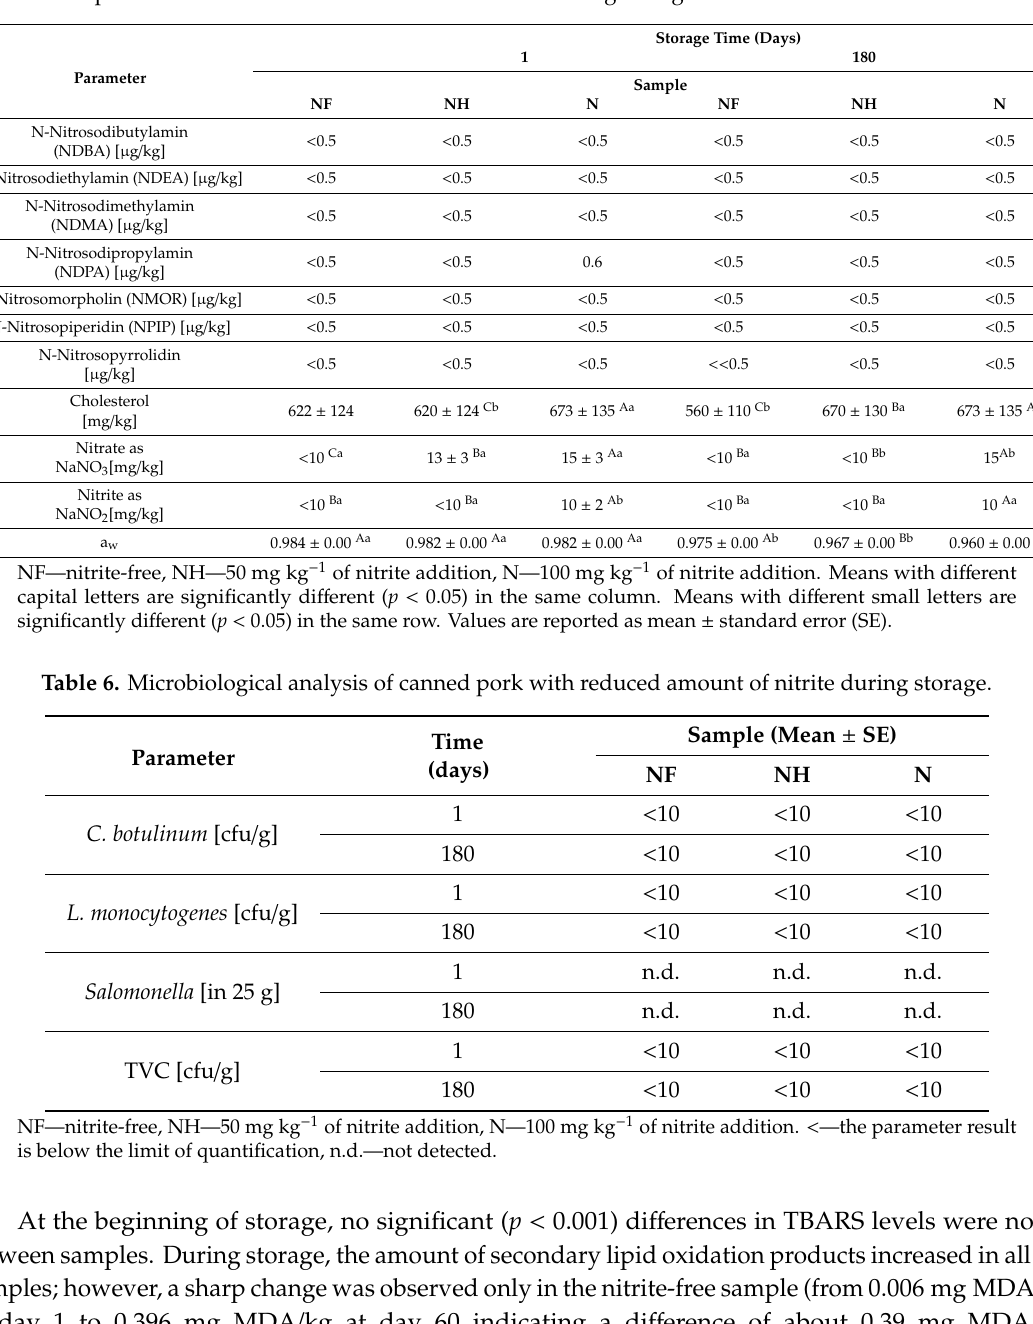
Table 5. Nitrosamine, cholesterol, nitrite and nitrate residues and water activity (a w ) amounts of canned pork with reduced amount of nitrite addition during storage. Parameter